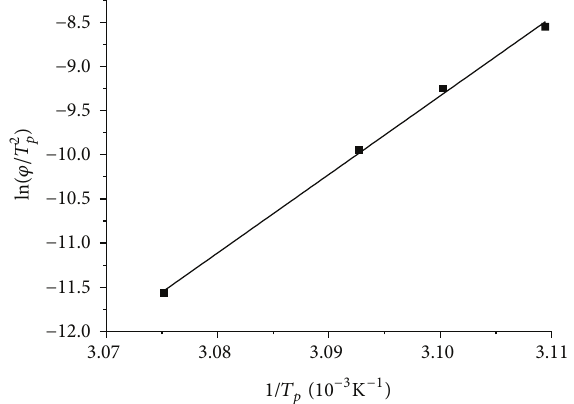
Figure 5: The plot of ln (𝜑/𝑇 2 𝑝 ) versus 1/𝑇 𝑝 for the MAG organogels.